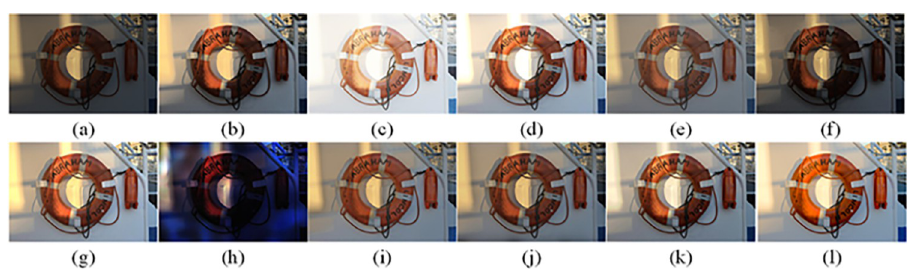
Fig 15. Comparisons of the ten algorithms in enhancing low-light image 5. (a) low-light image (b) AGCWD (c) Al- Ameen (d) BHE2PL (e) BIMEF (f) BPDHE (g) LIME (h) MSRCR (i) NPEA (j) SRIE (k) OURS (l) Normal light image.